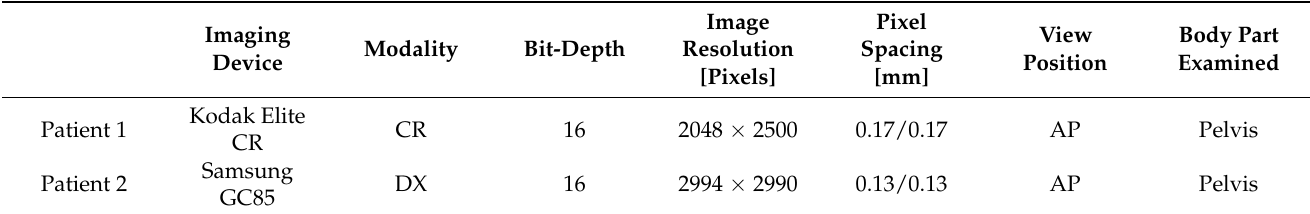
Table 1. Technical and metadata information of X-ray image datasets per patient.